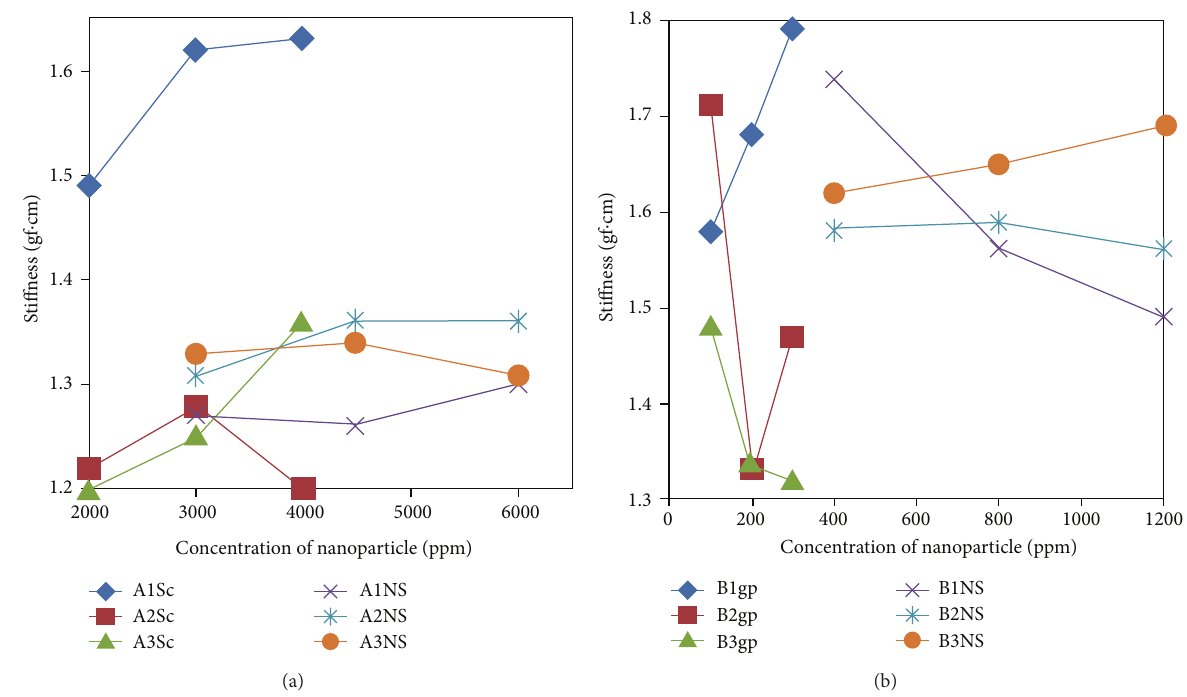
Figure 6: Effect of NS substituting for (a) Sc or (b) gp on the stiffness of the resulting handsheets.